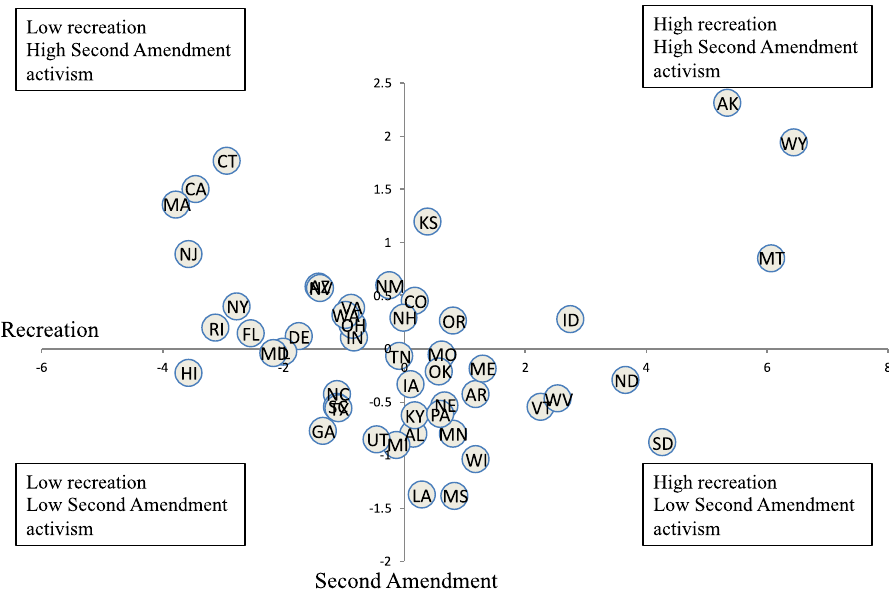
Fig. 5 Mix of state subcultures: Recreation/Second Amendment. Standardized component scores (representing the difference for a particular state from the mean for all states expressed in number of standard deviations) are shown for Recreation on the x -axis and for Second Amendment activism on the y